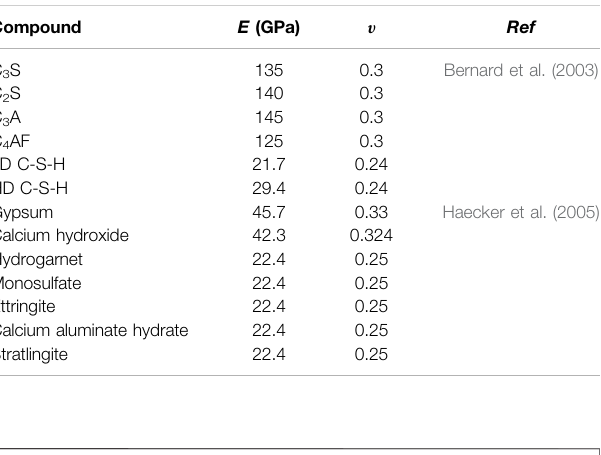
TABLE 2 | Elastic parameters of components.